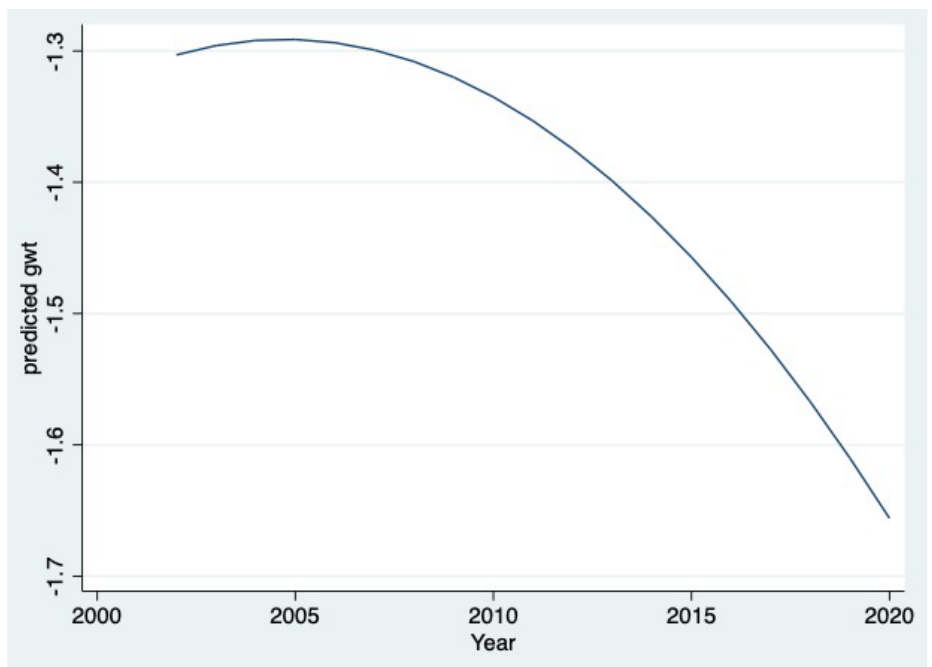
Figure 12. Average decline of 32 cm of GWT (m below surface) in the Hula Valley: annual averages of bi-weekly measurements in 32 drills distributed throughout the entire valley during 1993–2020.